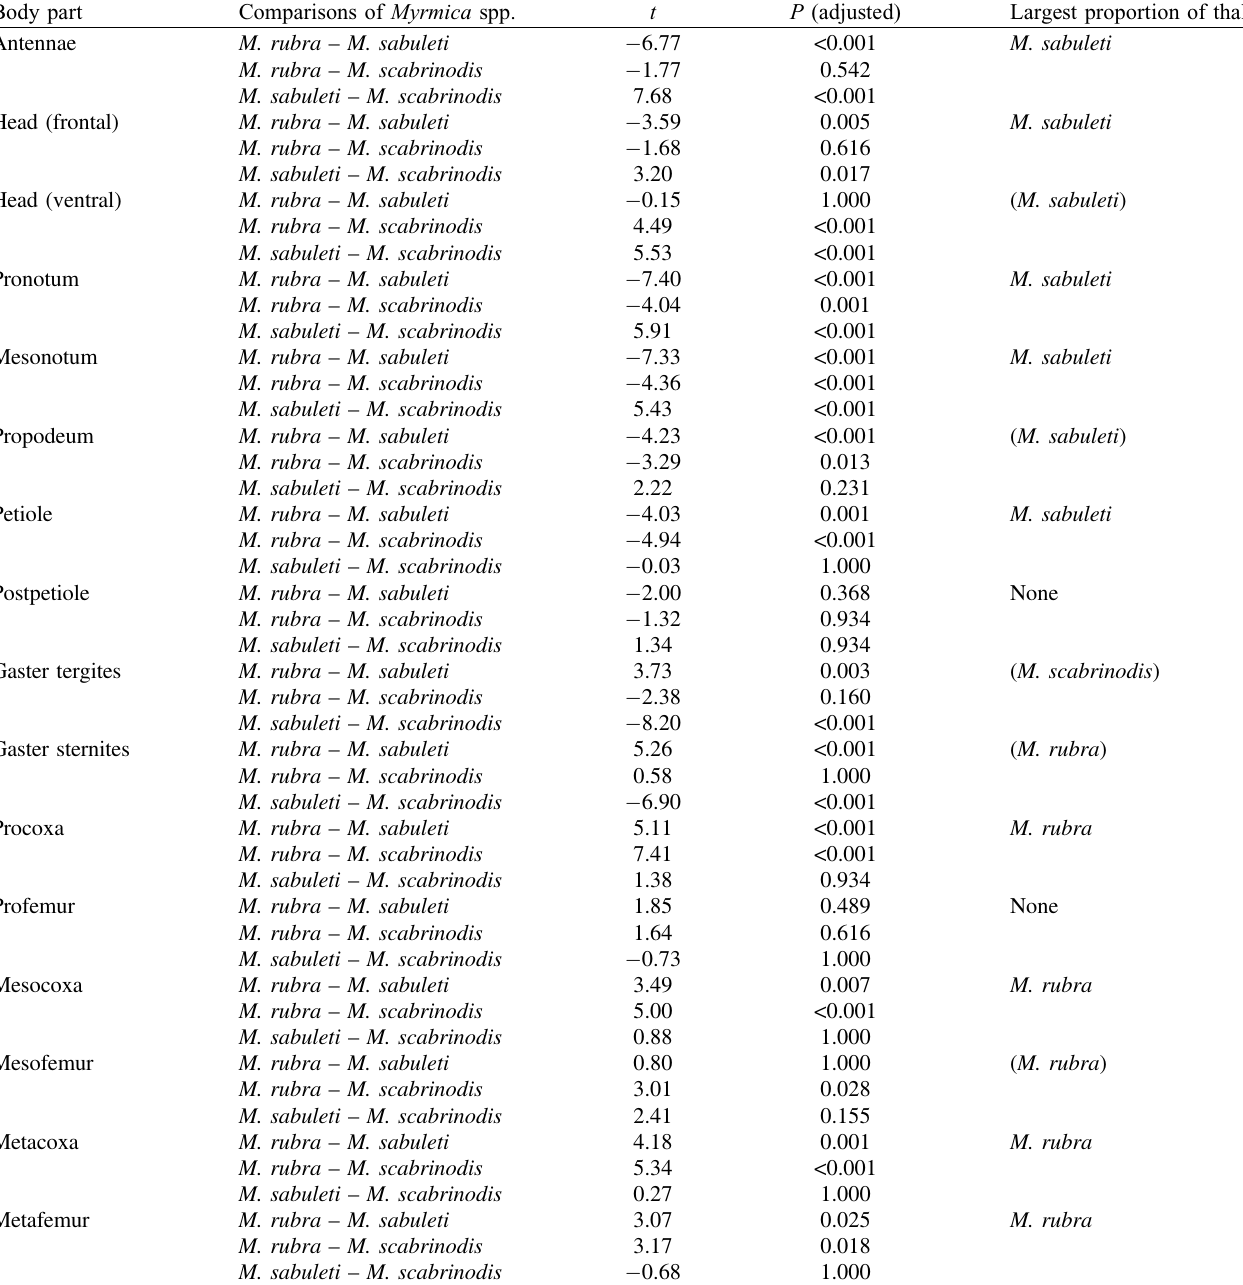
Table 6. Results of Conover-Iman tests on the species differences of body parts in relative thallus number. The column “ Largest proportion of thalli ” shows which host species had highest proportion of thalli on a given body part; species names in parentheses indicate that the difference between the speci fi ed species and one of the other two species is not signi fi cant; “ none ” means that the three species did not differ signi fi cantly from one